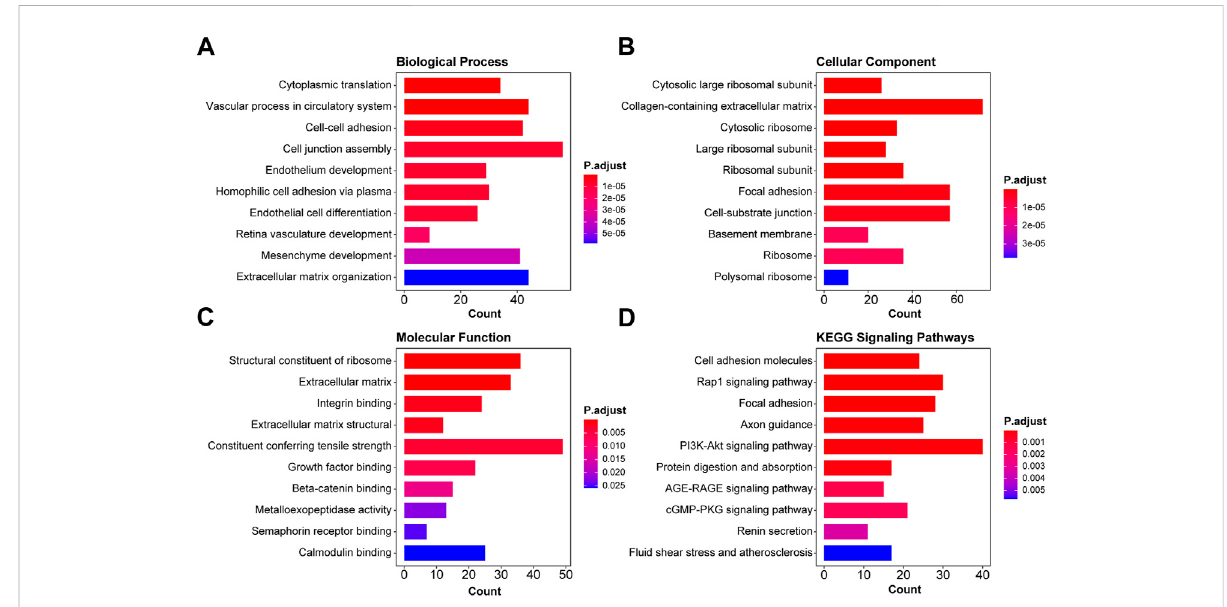
FIGURE 3 Functional enrichment analysis of differentially expressed genes in pre-eclampsia. Based on the 1,891 dysregulated genes, the functional enrichment analysis was conducted, and the top 10 GO enrichment items and KEGG items of interest were shown in the pattern of biological function (A) , cellular component (B) , molecular function (C) , and KEGG signaling pathways (D)